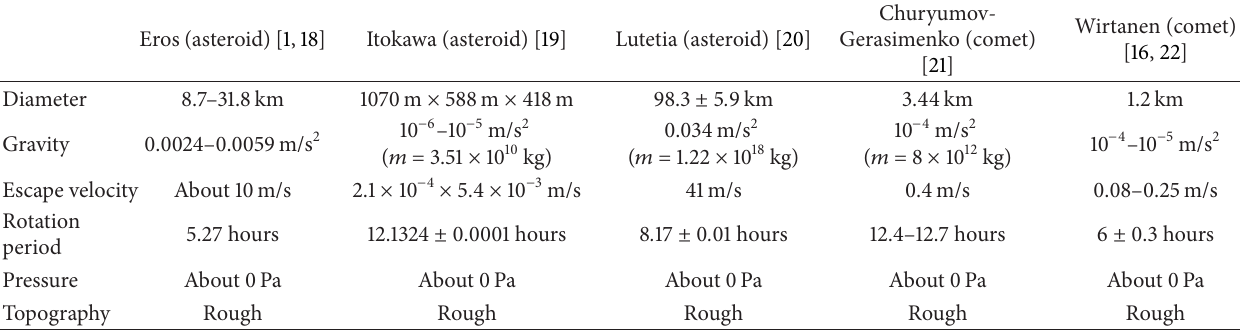
Table 1: Landing environments of some asteroids and comets.